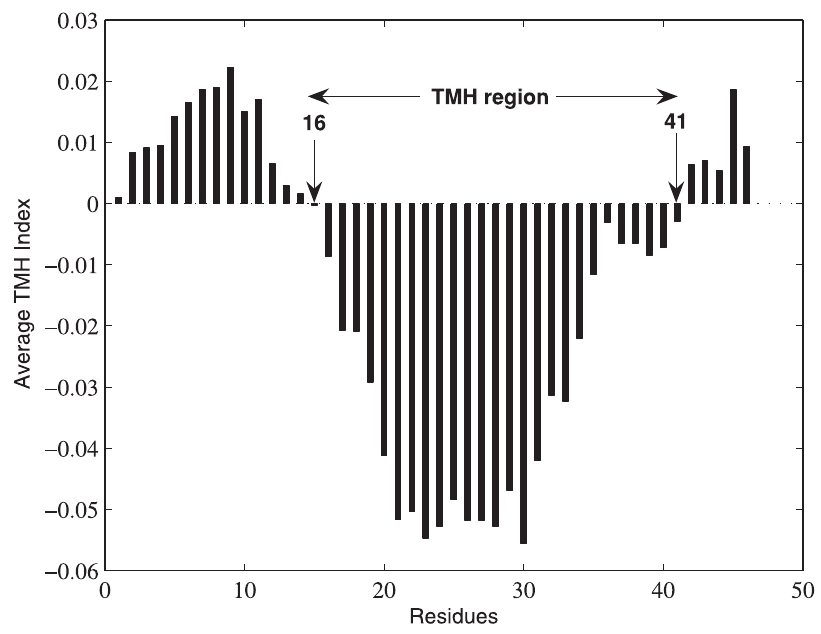
Figure 5. TMH segment detection in protein 1OCC using the index t i .